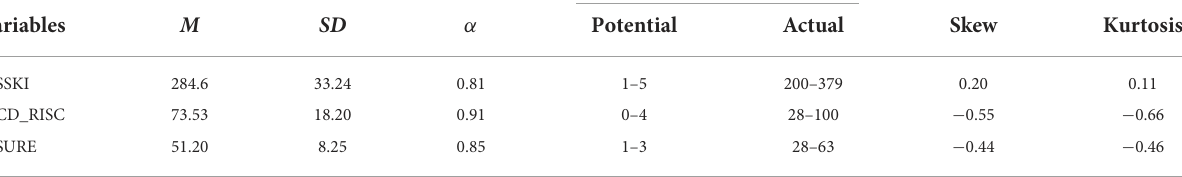
TABLE 1 Psychometric properties of the major study variables ( N = 100).